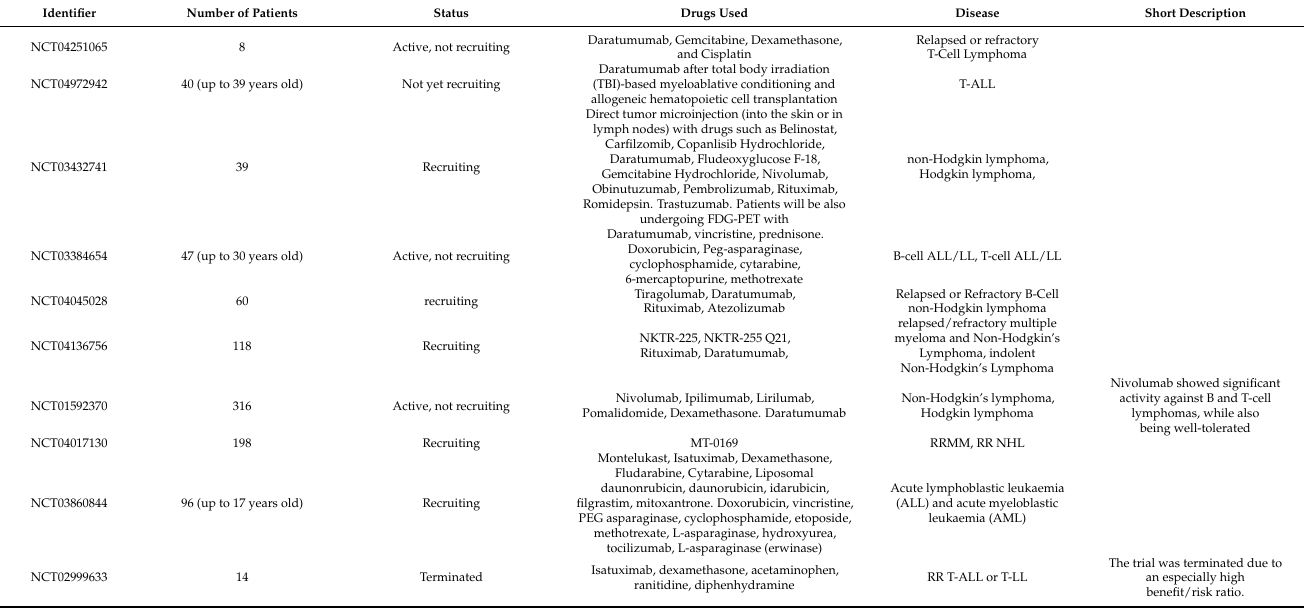
Table 5. Daratumumab and Isatuximab in Lymphomas and Acute lymphoblastic leukaemia.